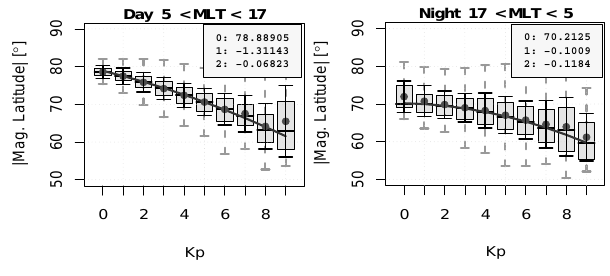
Fig. 10. Average latitude distribution of 50-Hz current density (cid:12) (cid:12) peaks, (cid:12) j 50Hz , peak (cid:12) , as a function of K p index. The format is the same as in Fig. 9.